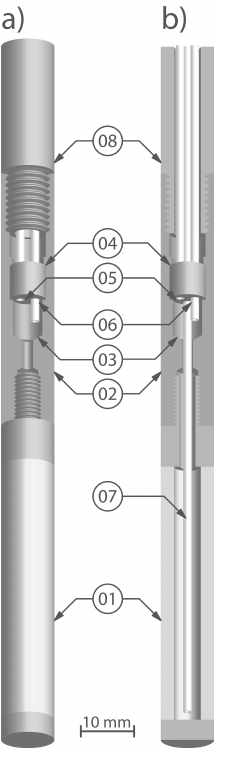
Figure 2. Schematic three-dimensional representation of the in situ soil water isotope probes according to (a) the ADS and (b) the DDS method. Labels indicate (1) microporous tube, (2) central element, (3) mixing chamber, (4) line retainer, (5) sample line, (6) dilution line, (7) throughflow line, and (8) insertion and protection